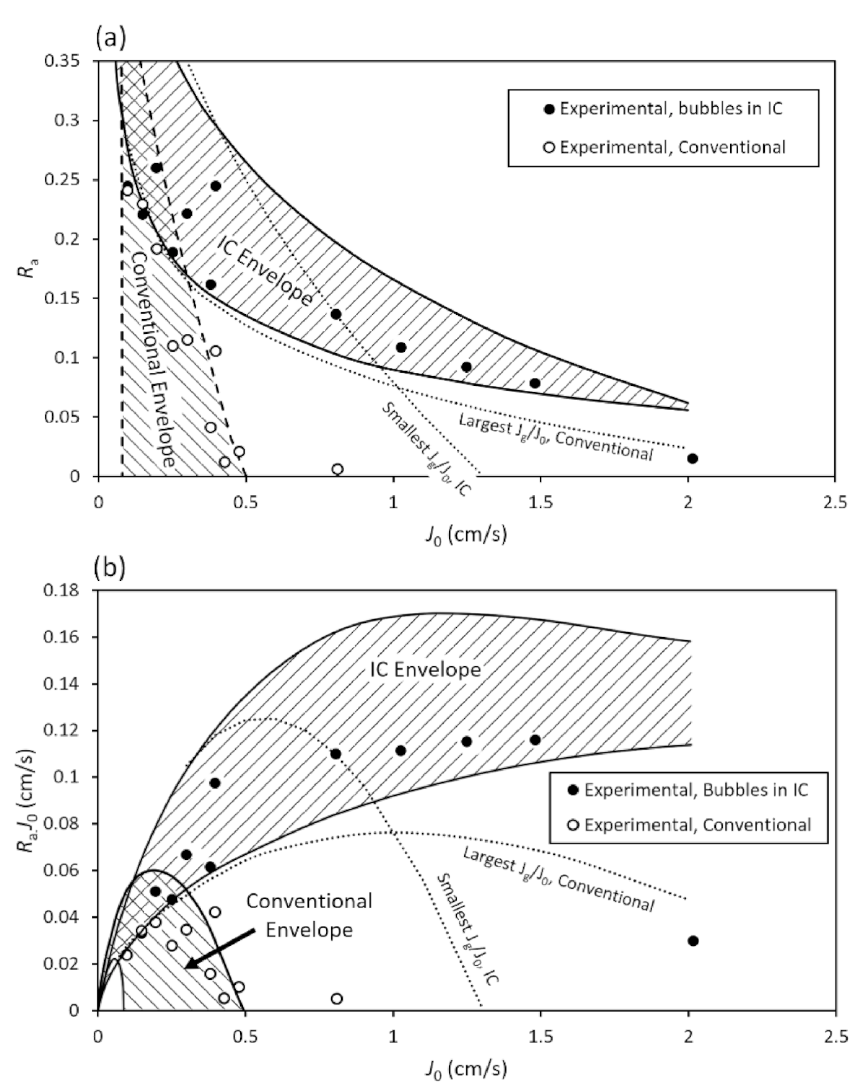
Figure 7. Envelope of modeled values of ( a ) adsorptive recovery and ( b ) extraction rate for V = 5, with both conventional operation and bubbles in the IC. Outlying cases (dotted curves) are discussed in the